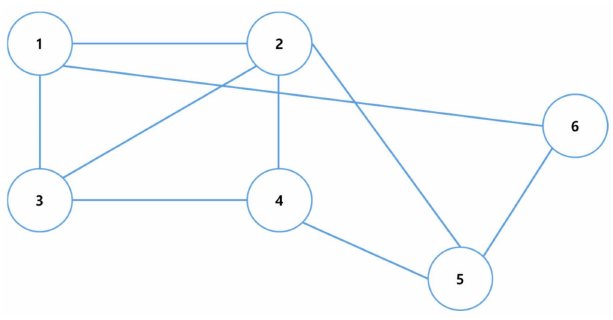
Figure 1. Simplest form of